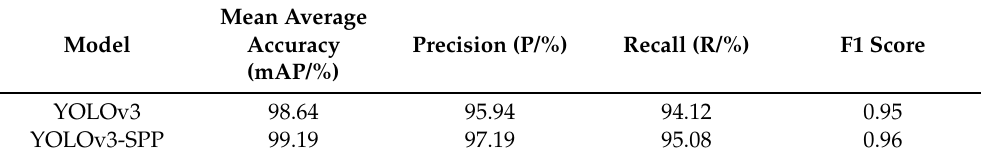
Table 3. Comparison of YOLOv3 and YOLOv3-SPP.